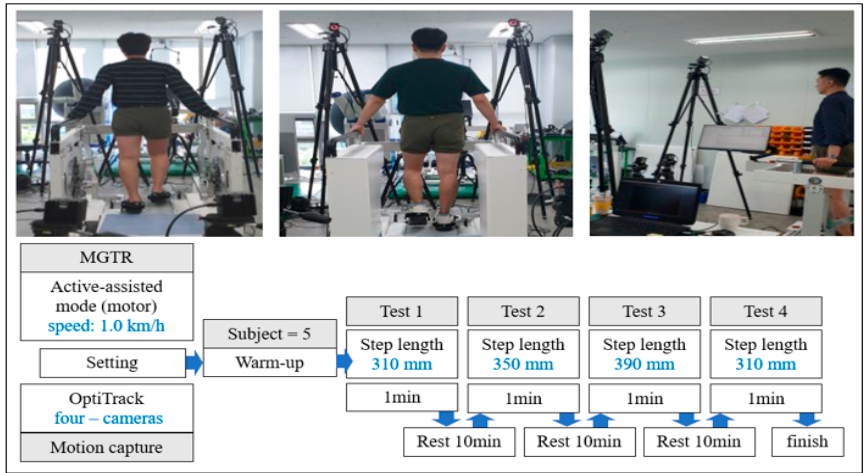
Figure 8. Experiment scene and flow chart.